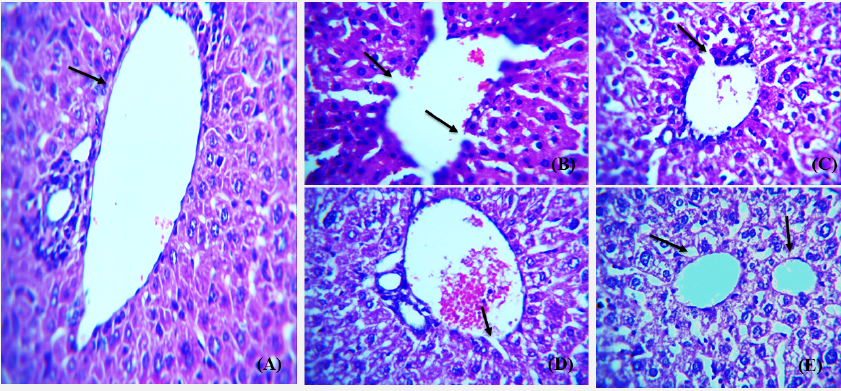
Figure 19. Representative images showing Hematoxylin and Eosin stained (H&E) (×40) sections of liver. ( A ) Control, normal liver histology with portal triad and portal vein (arrow) with hepatocytes radiating from the portal vein. ( B ) Diabetic group showing complete distortion of portal vein architecture and congestion of portal triad. ( C ) Diabetic metformin-treated group showing somewhat restoration of hepatic architecture but dilated vascular channels. ( D ) Diabetic mice liver treated with 5 mg/kg AgNPs showing greater restoration of portal vein boundary with little dilation (arrow) and normal portal triad. ( E ) Diabetic AgNP (10 mg/kg) treated mice liver showing restored architecture comparable to that of normal with intact portal triad and normal physiology of kupffer cells (arrow).